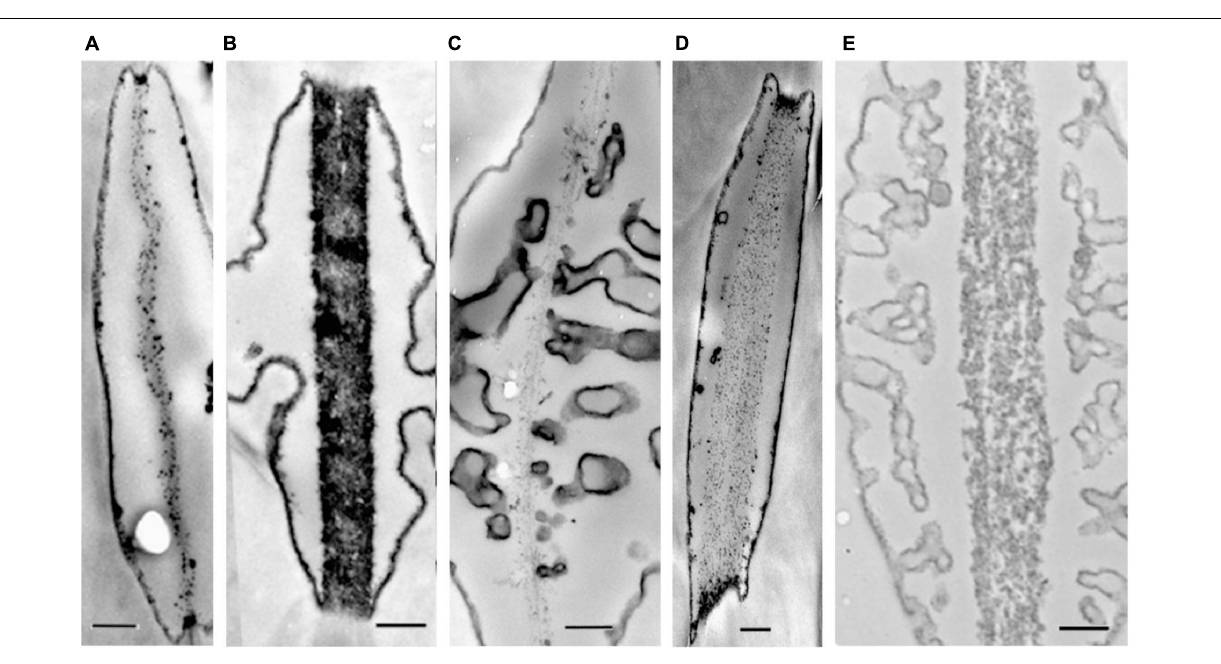
FIGURE 4 | Transmission electron microscopy images of transverse sections of intervessel pit membranes of five of our focal species (A) Guatteria dumetorum (tree), (B) Pleonotoma variabilis (liana), (C) Tachigali versicolor (tree), (D) Cordia alliodora (tree), (E) Stigmaphyllon hypagyreum (liana). Vestured pits occur in (B,C,E) . Scale bar is 200